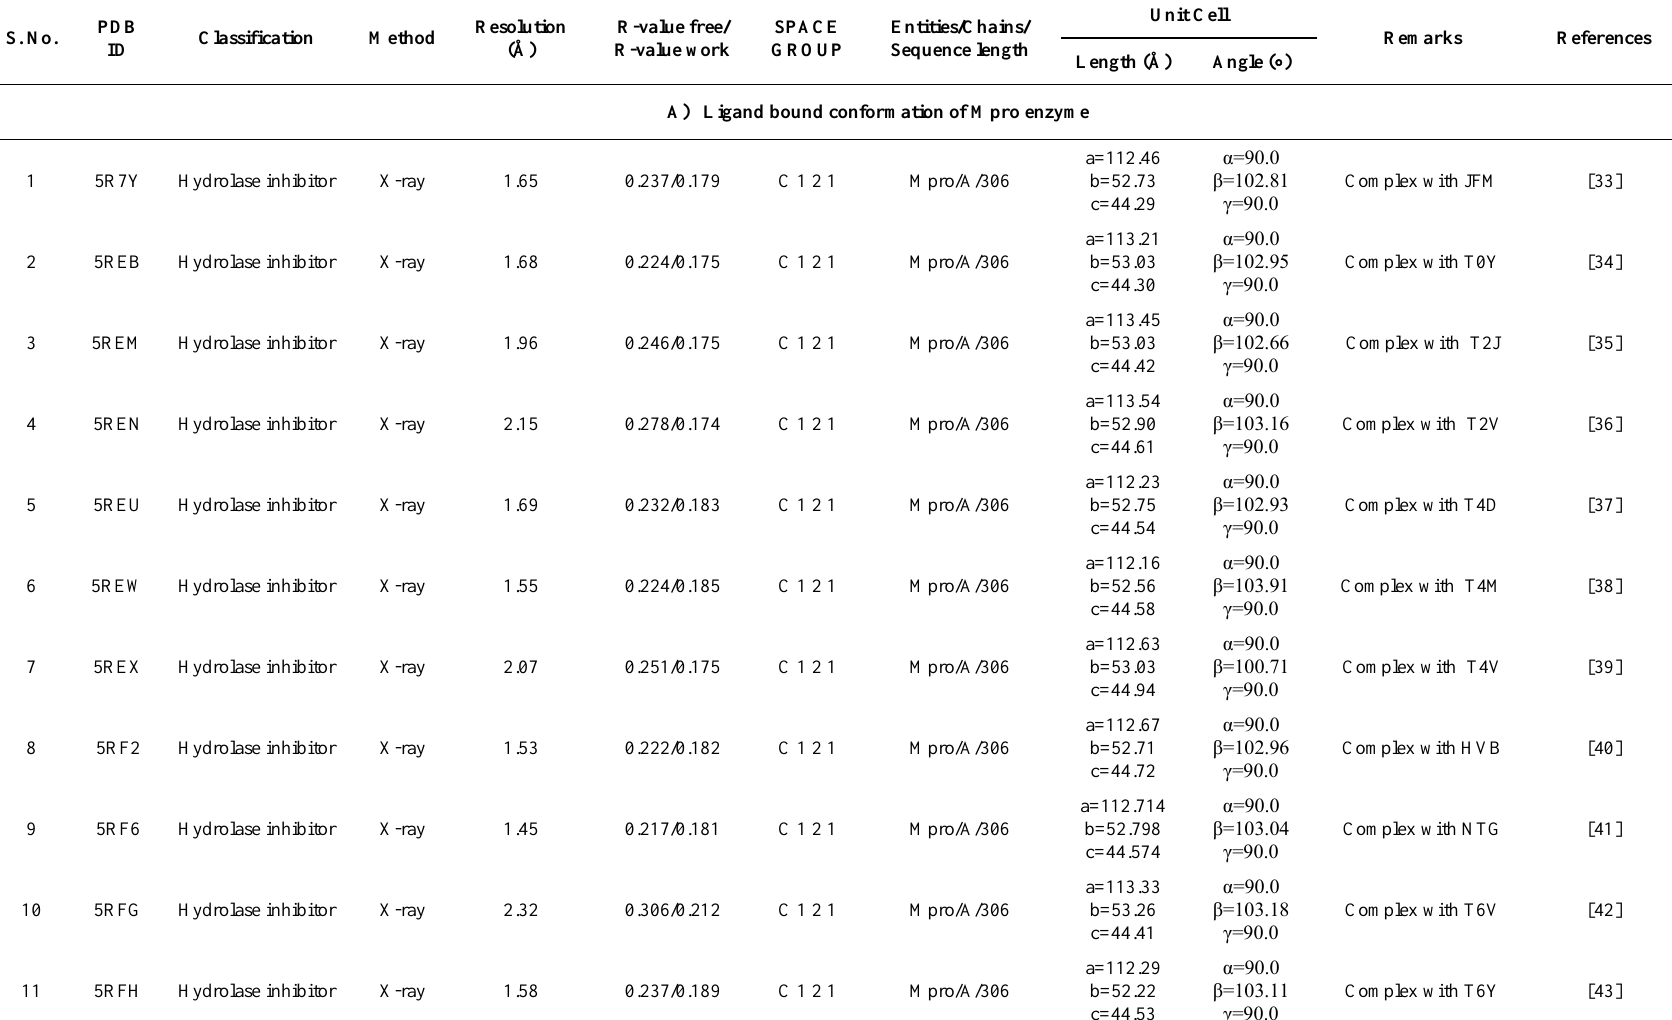
Table S1. List of X-ray crystal structures of Main Protease (Mpro) enzyme and RBD of spike protein of SARS-CoV-2 in the study. S.